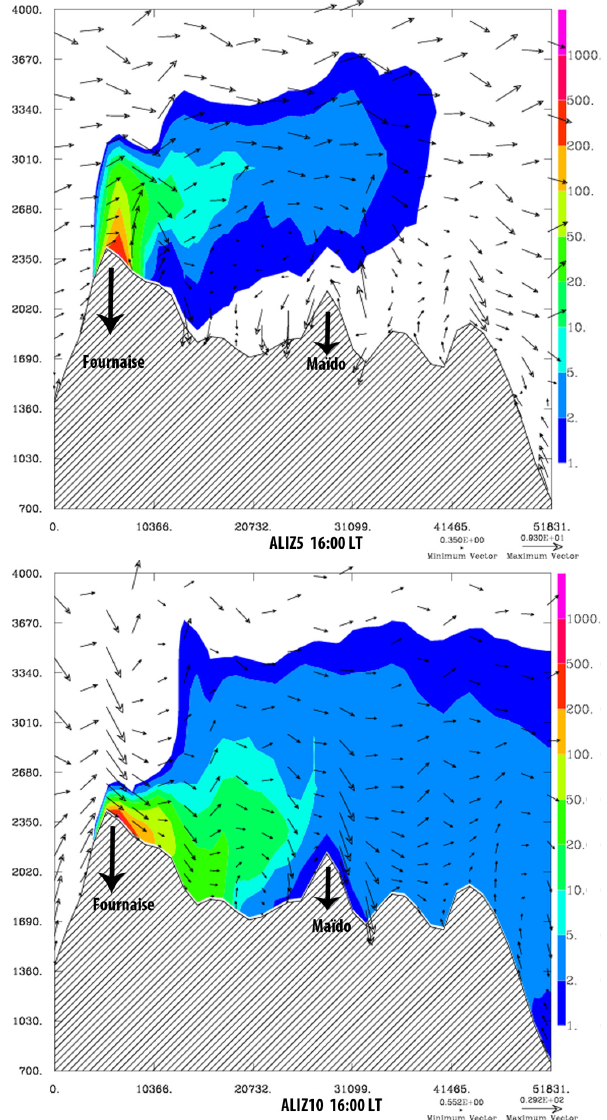
Fig. 16. Vertical cross section Fournaise (21.25 ◦ S/55.76 ◦ E) – Ma¨ıdo (21.03 ◦ S/55.32 ◦ E) (indicated on Fig. 9, bottom) of volcanic tracer dilution ratio (per mil of the concentration at emission point) at 16:00LT (top: ALIZ5, bottom: ALIZ10).